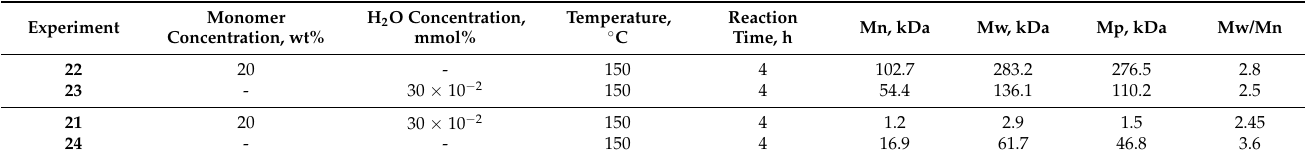
Table 3. Data from experiments 21 – 24 with water.